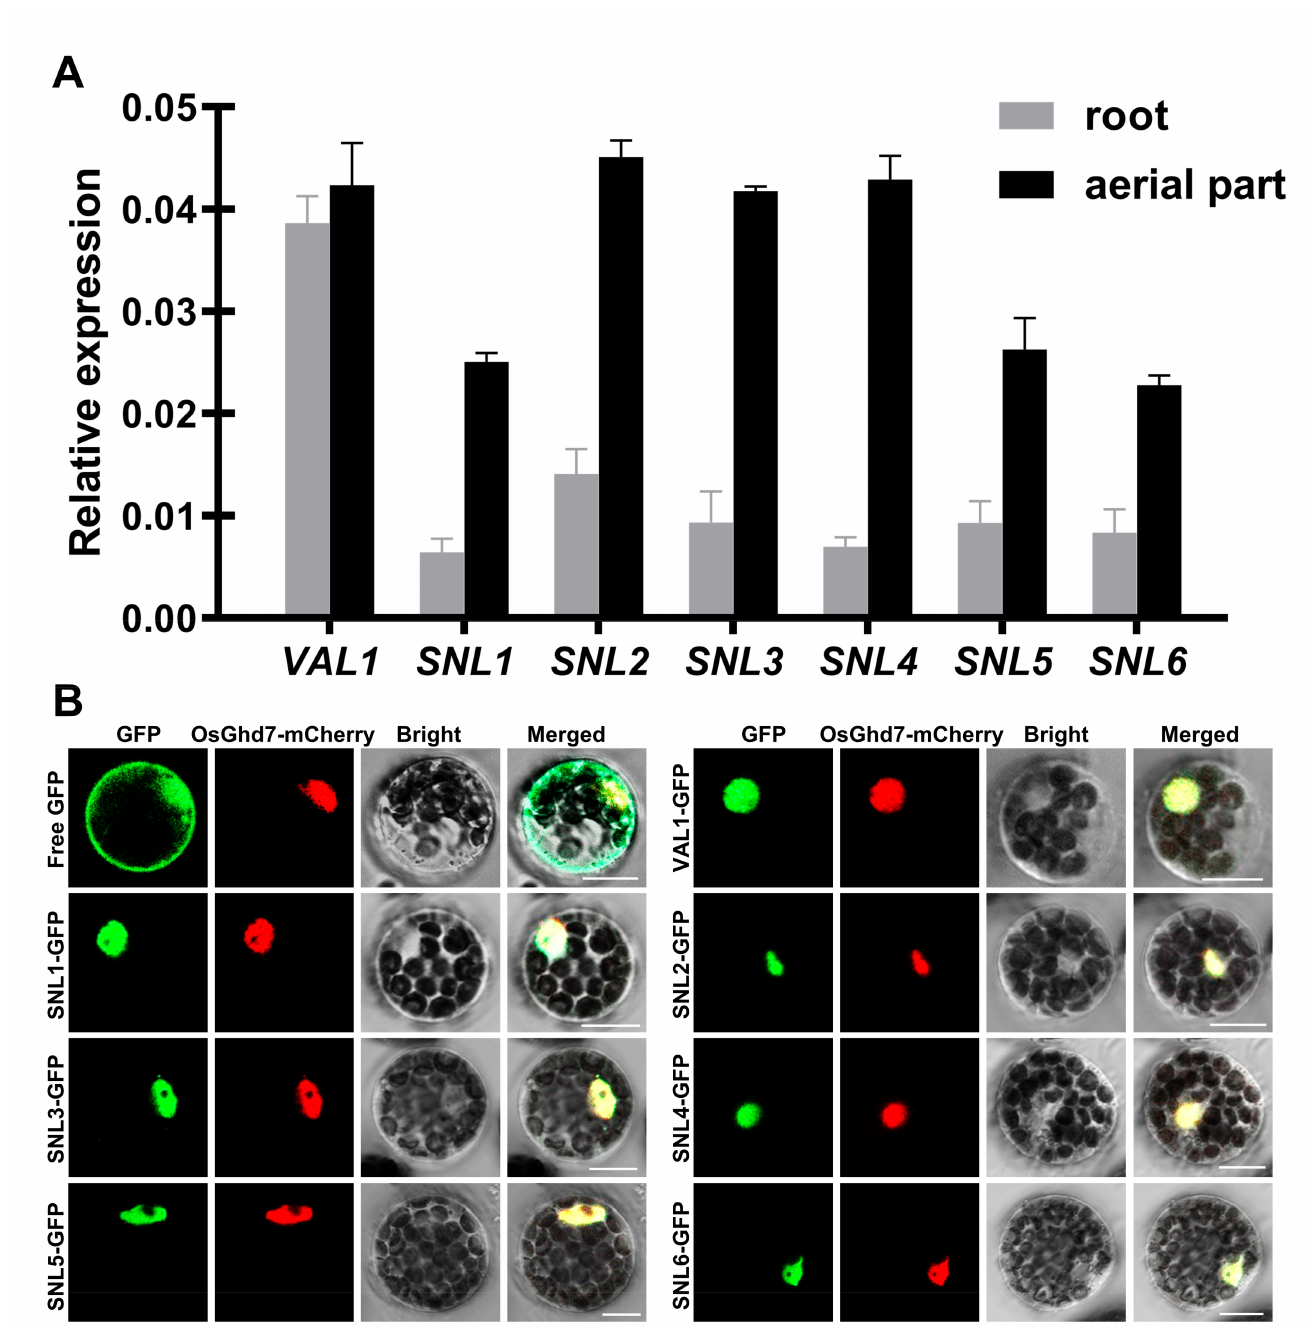
Figure 5. Expression pattern analysis of VAL1 and SNLs , and subcellular localization of the VAL1 and SNLs proteins. ( A ) Expression pattern analysis of VAL1 and SNLs in Arabidopsis seedlings that were 2 weeks old. Transcript abundance was determined using qRT-PCR with Tub2 as a reference. Values are presented as means ± SD ( n = 3). ( B ) Subcellular localization of the VAL-GFP and SNLs-GFP fusion proteins in Arabidopsis protoplasts. OsGhd7-mCherry was used as a nuclear marker. Free GFP was used as the control. VAL1-GFP or SNLs-GFP was co-transformed into Arabidopsis protoplasts with OsGhd7-mCherry, and overlapping GFP and mCherry signals were observed in the nucleus. Bars = 10 µ